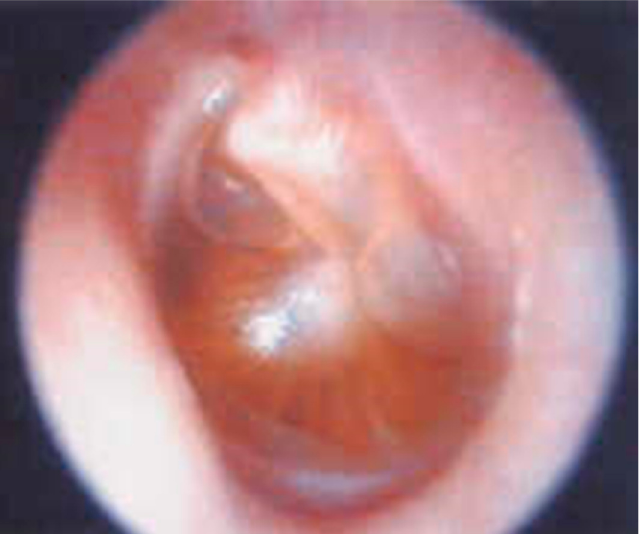
Figure 3. Tympanic membrane with middle-ear effusion but without signs of acute inflammation in a 1-year-old child.